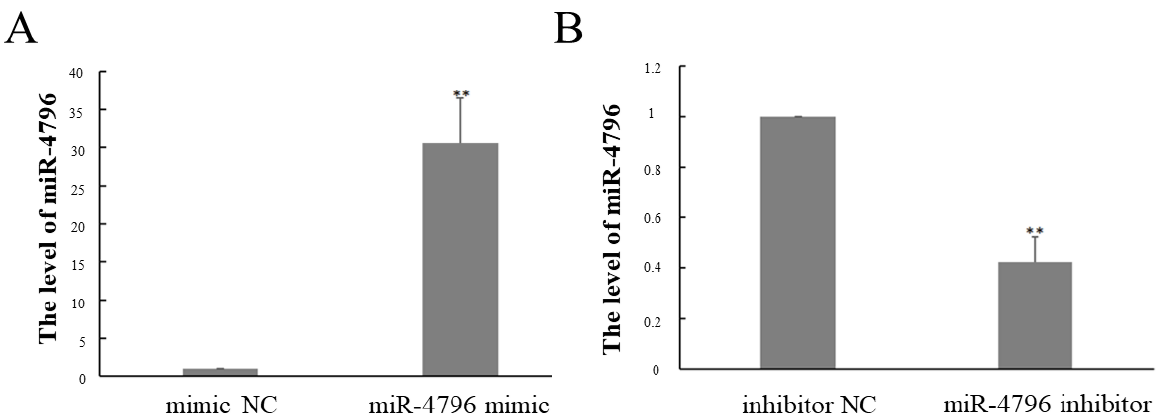
Figure 1. Expression level of miR-4796. ( A ): Expression level of miR-4796 transfected with miR-4796 mimic; ( B ): Expression level of miR-4796 transfected with miR-4796 inhibitor. Each value represents the mean ± SD ( n = 3). ** p < 0.01 compared with the NC group.